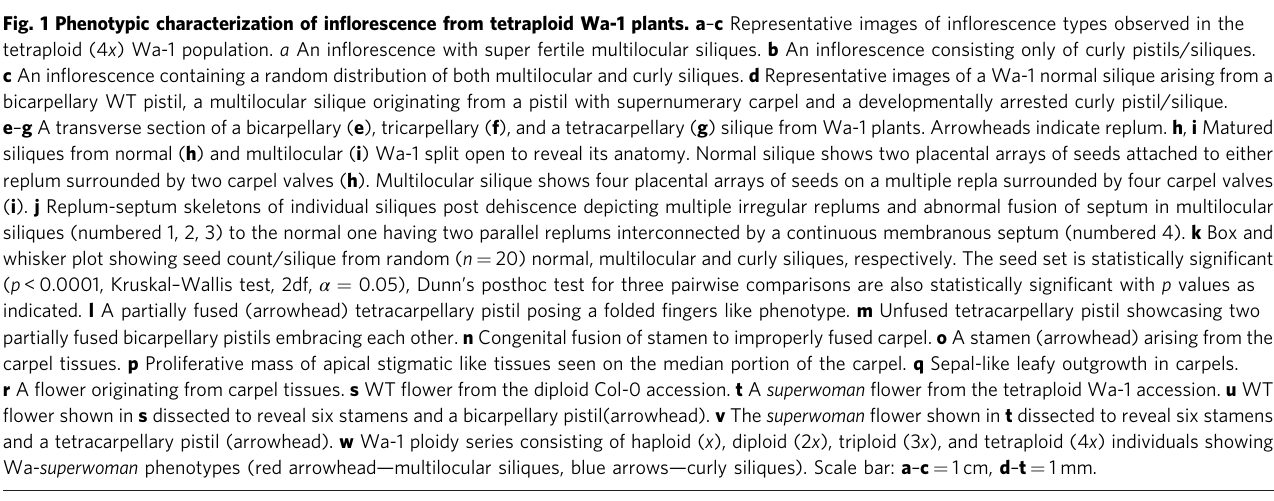
Fig. 1 Phenotypic characterization of in fl orescence from tetraploid Wa-1 plants. a – c Representative images of in fl orescence types observed in